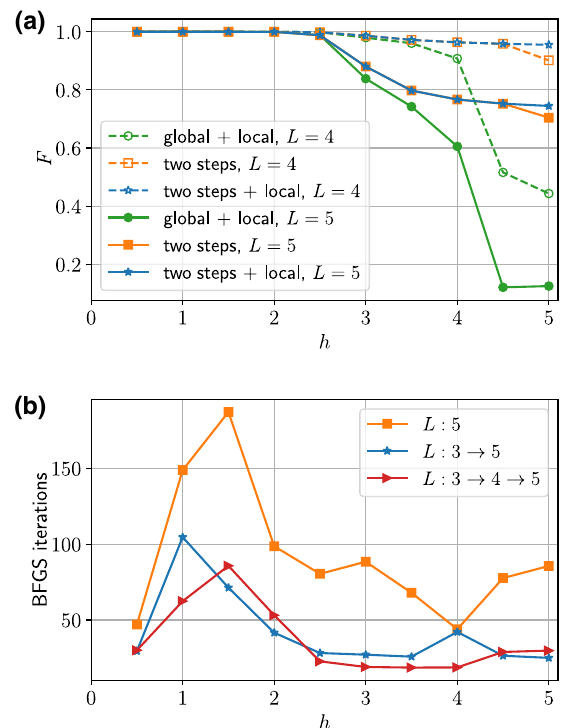
FIG. 14. (a) Comparison of the two-step versus global sched- ules for L = 3 as an educated guess for optimization on larger system sizes L = 4, 5. The data refer to the best out of ten local BFGS minimizations, run by starting close to the opti- mal two-step schedule (blue stars) or optimal global-schedule (green circles). The plot also shows the fidelity of the optimal two-step schedule (orange squares) for L = 4, 5. (b) Number of iterations required for the convergence of the final BFGS opti- mization; comparison between transferring the schedule from L = 3 to L = 5 (blue stars), transferring from L = 4 to L = 5 (red triangles), and two-step optimization directly on L = 5 (orange squares). All data refer to P = 6 and | ψ 0 (cid:3) = | (cid:5) E (cid:3)